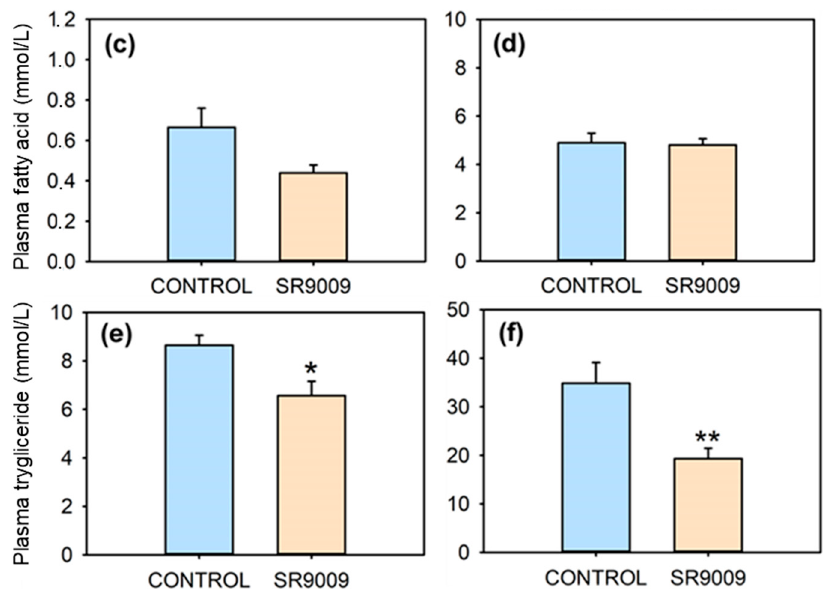
Figure 5. Effect of acute and subchronic SR9009 treatment on plasma levels of glucose ( a , b ), fatty acid ( c , d ), and triglyceride ( e , f ) in goldfish ( Carassius auratus ) treated with vehicle alone (CONTROL) or containing SR9009 (100 µ g/g bw). Data are expressed as mean + S.E.M. (acute, n = 9/group; subchronic, n = 12/group). * p < 0.05, ** p < 0.01 SR9009 compared to control group (Student’s t -test).